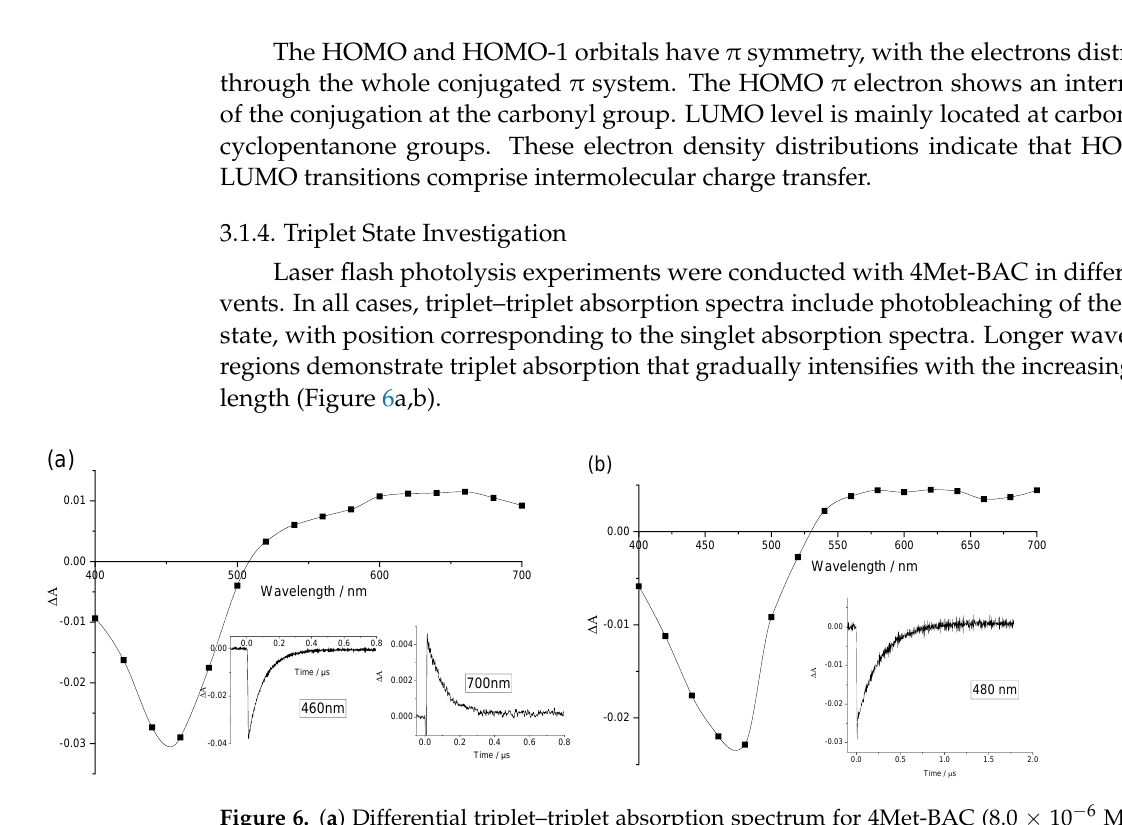
Table 3. 4Met-BAC triplet state characteristics in different conditions. Solvent